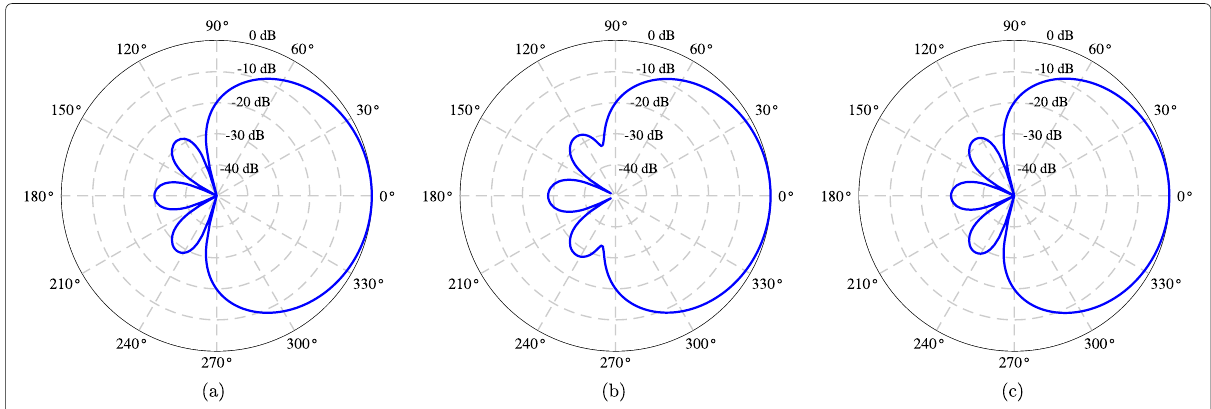
Fig. 13 Beampatterns designed with the conventional method in [51] and the proposed method: a the target beampattern (second-order supercardioid), b conventional method, and c proposed method